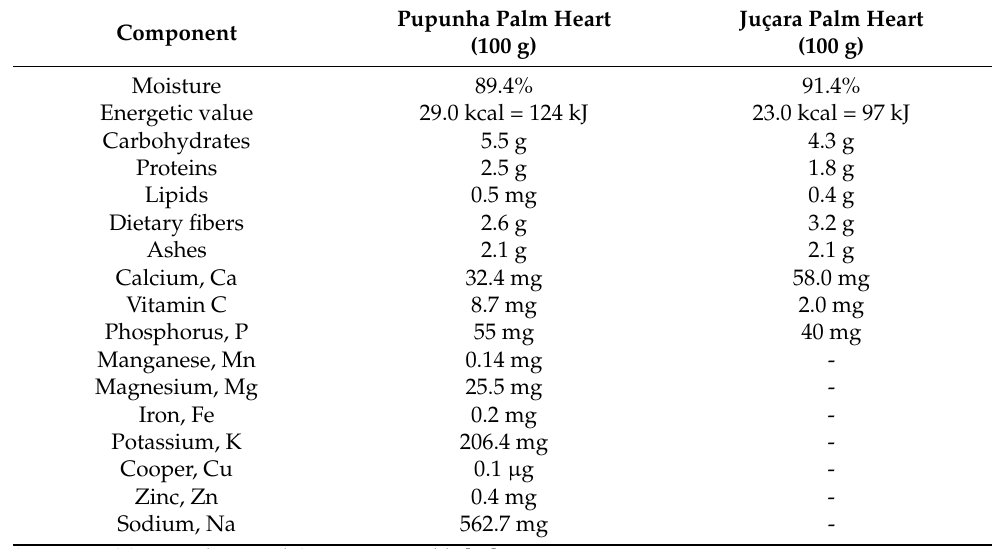
Table 3. Comparative nutritional composition of pupunha palm heart ( Bactris gasipaes Kunth) and juçara palm heart ( Euterpes edulis